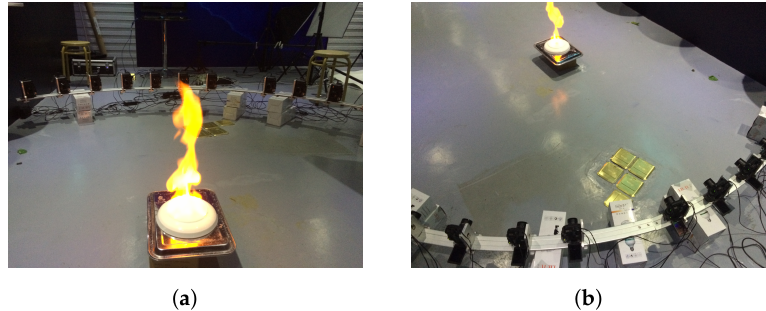
Figure 16. Flame video capture scene. ( a ) One view of the capture scene, ( b ) another view of the capture scene.